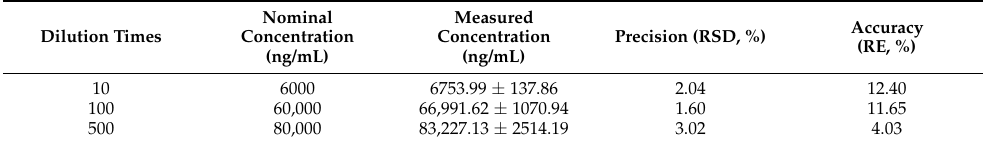
Table 3. The dilution reliability of 10, 100 and 500-fold dilution of plasma samples.